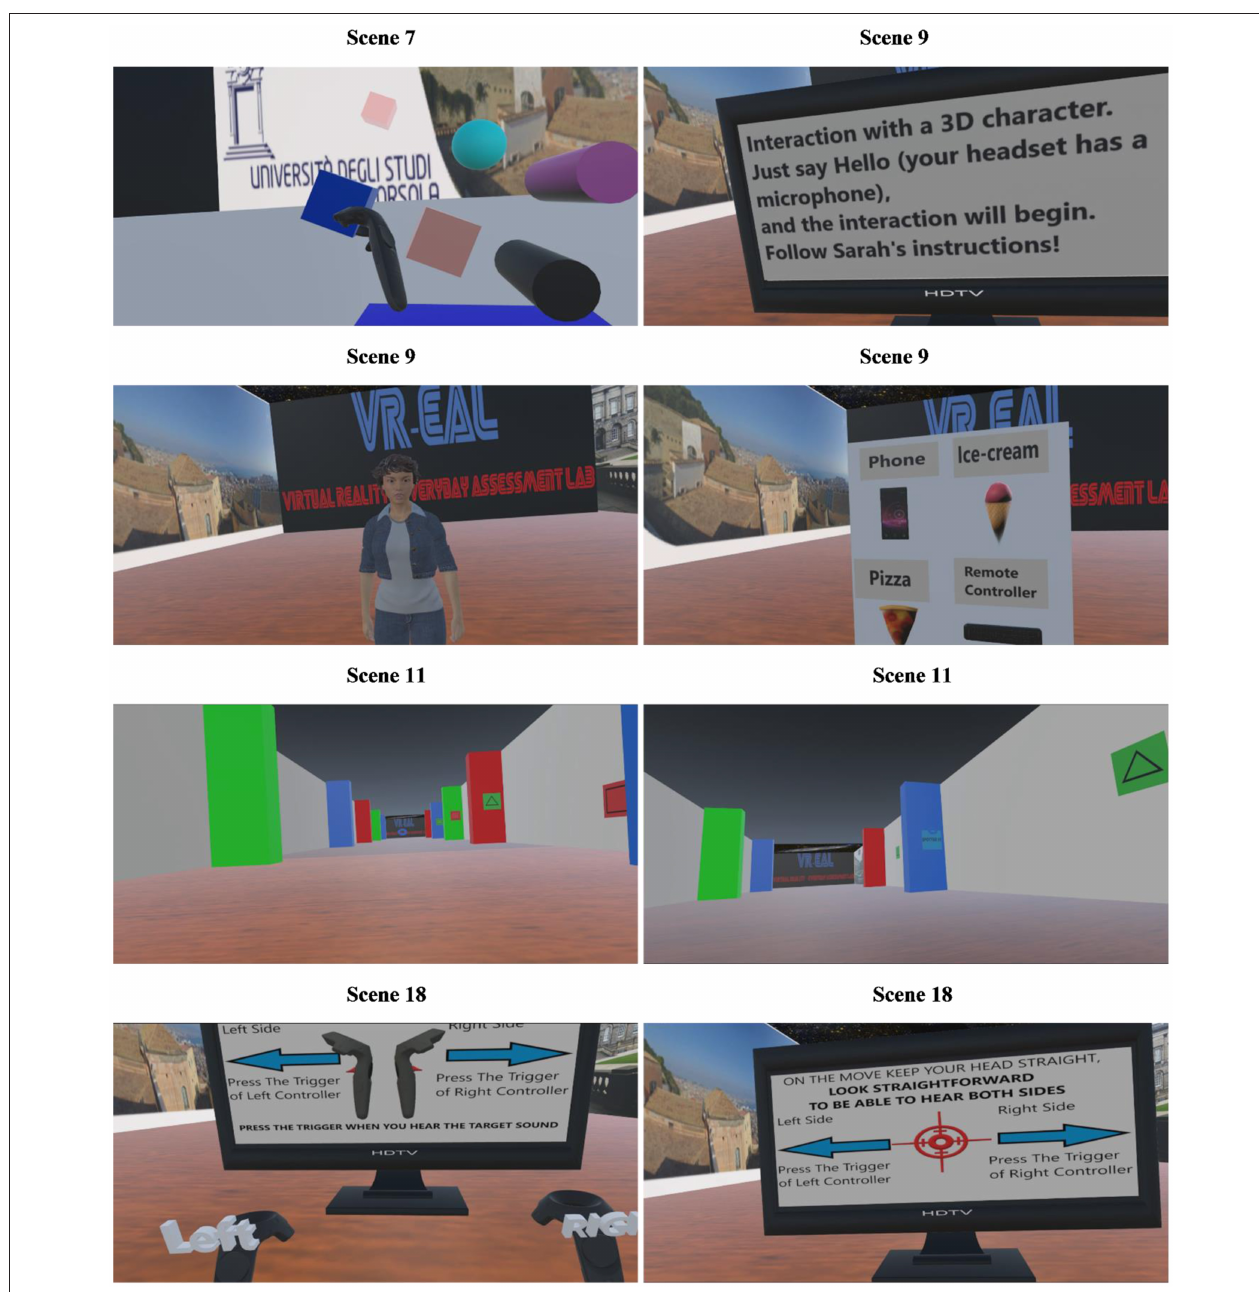
FIGURE 2 | VR-EAL tutorials: scenes